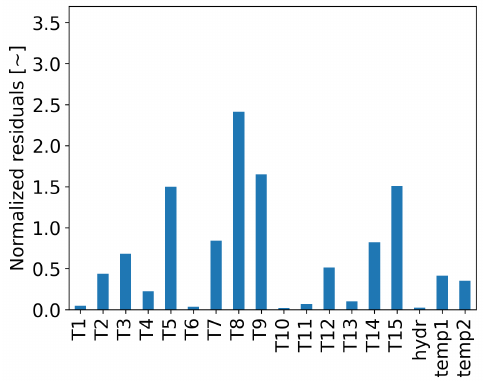
Figure 17. Autoencoder: bar plots of MAE residuals (December